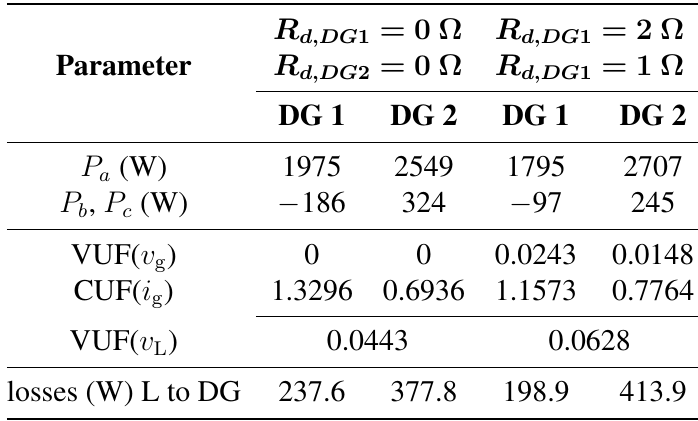
Table 11. Islanded microgrid: power sharing between two DG units with different ratings = 3 Ω ; R = 0 Ω ( R l v